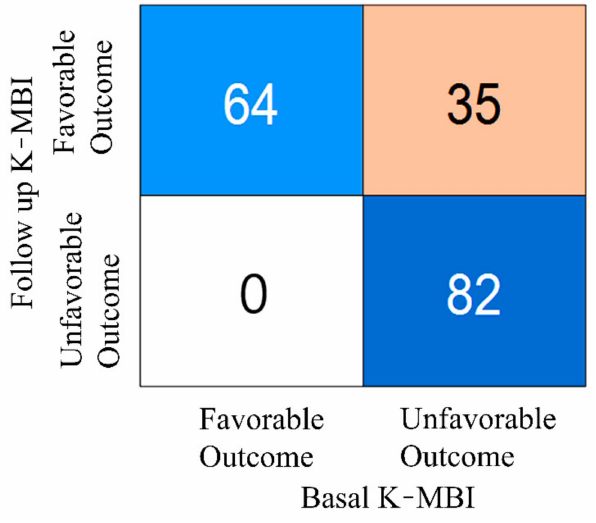
Figure 3. Numbers of patients in favorable and unfavorable groups at basal and follow-up examina- tions.